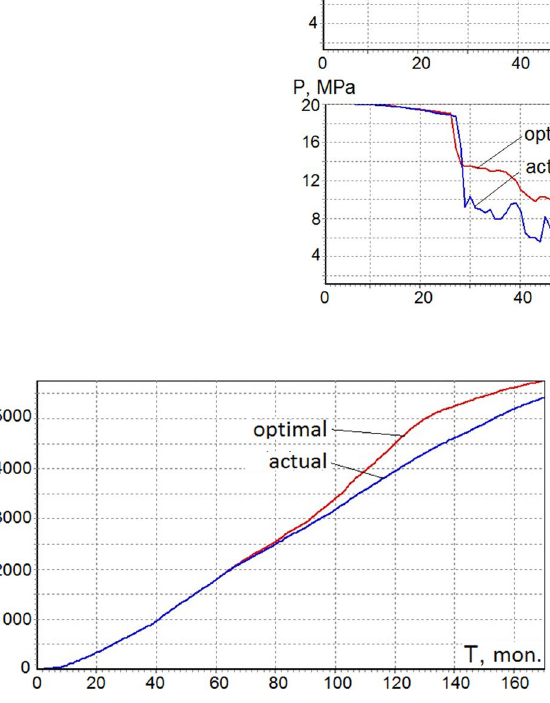
Fig. 5 Monthly gas production from the Kotelevske gas reservoir with optimal and «actual» modes of